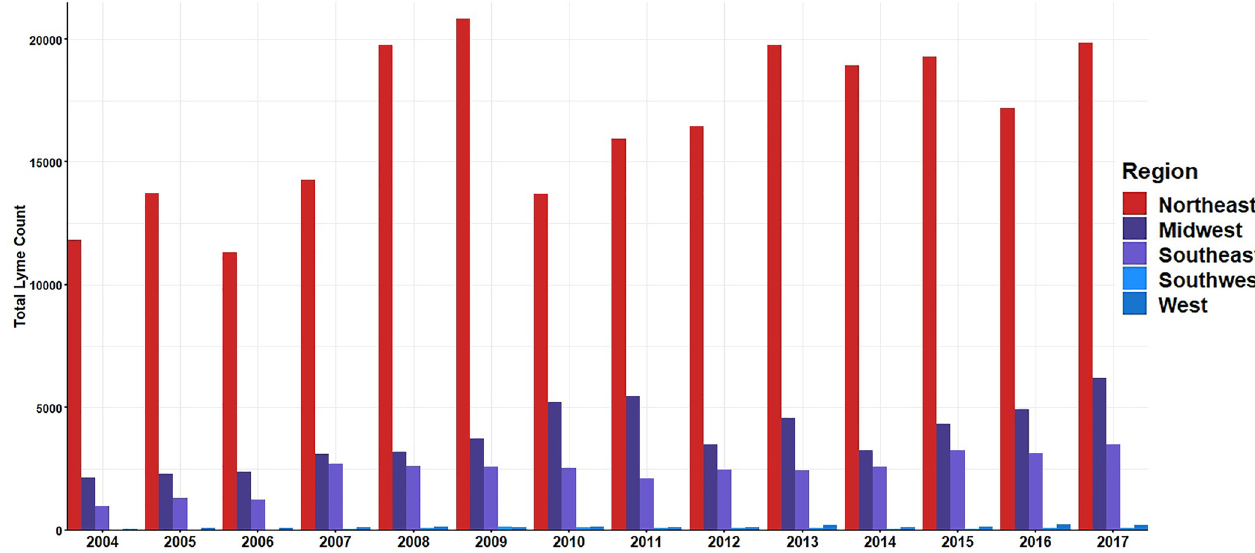
Fig 2. Regional Lyme disease incidence count from CDC surveillance. Incidence counts calculated by summing monthly state incidence form CDC surveillance in each region. Calculations and graphs made suing RStudio version 3.6.2.